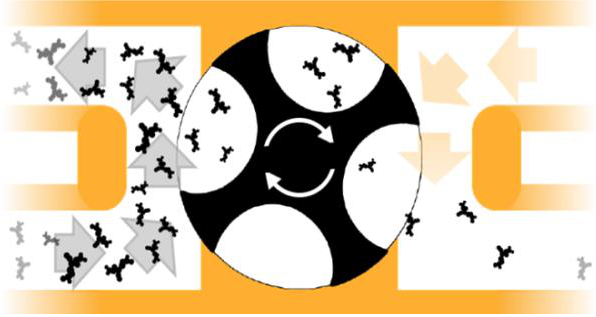
Fig. 3. View of the operation of the sample diluent tunnel [9]